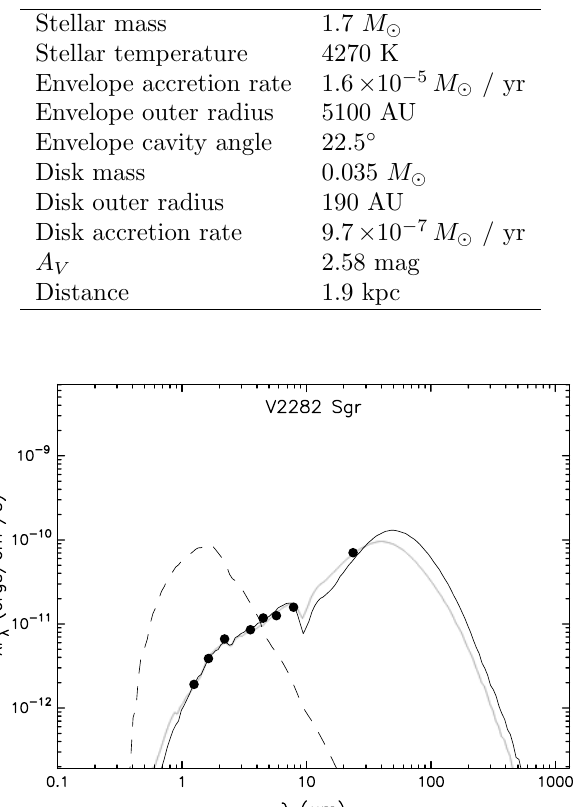
Table 5. Physical parameters of V2282 Sgr.